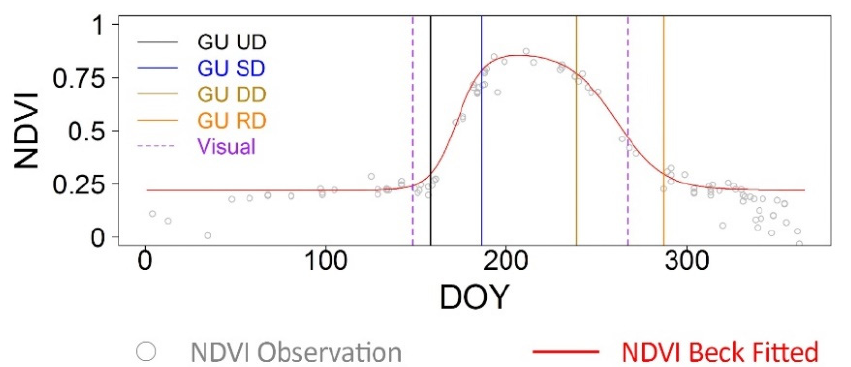
Figure 5. The PlanetScope NDVI observations fitted by the Beck double logistic model for the corn site of the University of Illinois Energy Farm in 2017. With the Beck fitted curve, four phenophase analysis methods (i.e., TRS-based, DER-based, CUR-based, and Gu-based methods) were employed to extract phenological metrics to be compared with corresponding visual observations. For this site-year, the visually observed crop emergence date was DOY 148, and the observed crop maturity date was DOY 267.